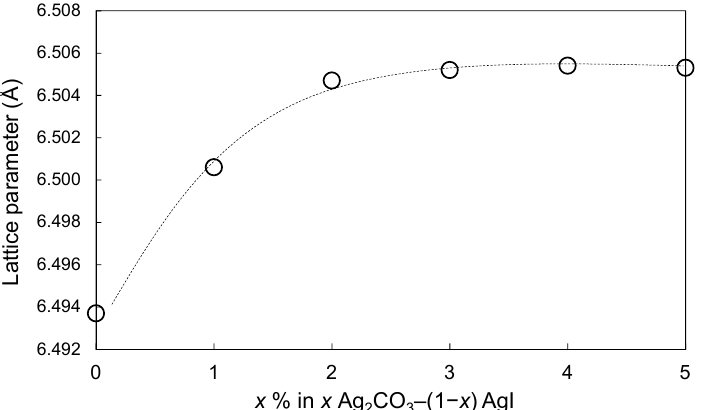
Figure 3. Change in lattice parameters refined using the Rietveld method against x in x Ag 2 CO 3 –(1– x )